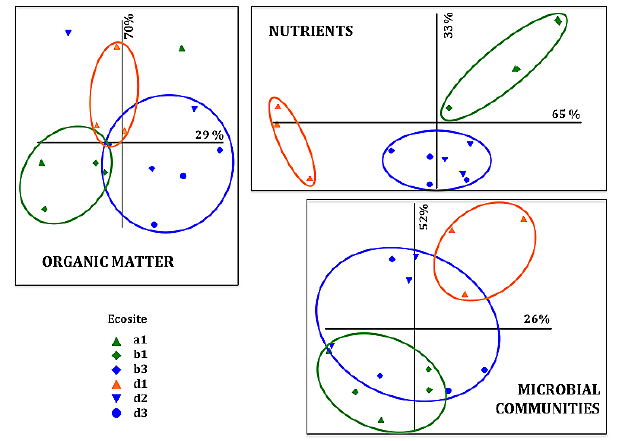
Fig. 1. NMS ordination biplots for soil nutrient supply (PRS), or- ganic matter composition (NMR), and microbial community struc- ture (PLFA) for the natural sites. Each point on the ordination corre- sponds to one site. Description of soil type and dominant vegetation for each ecosite are given in Table